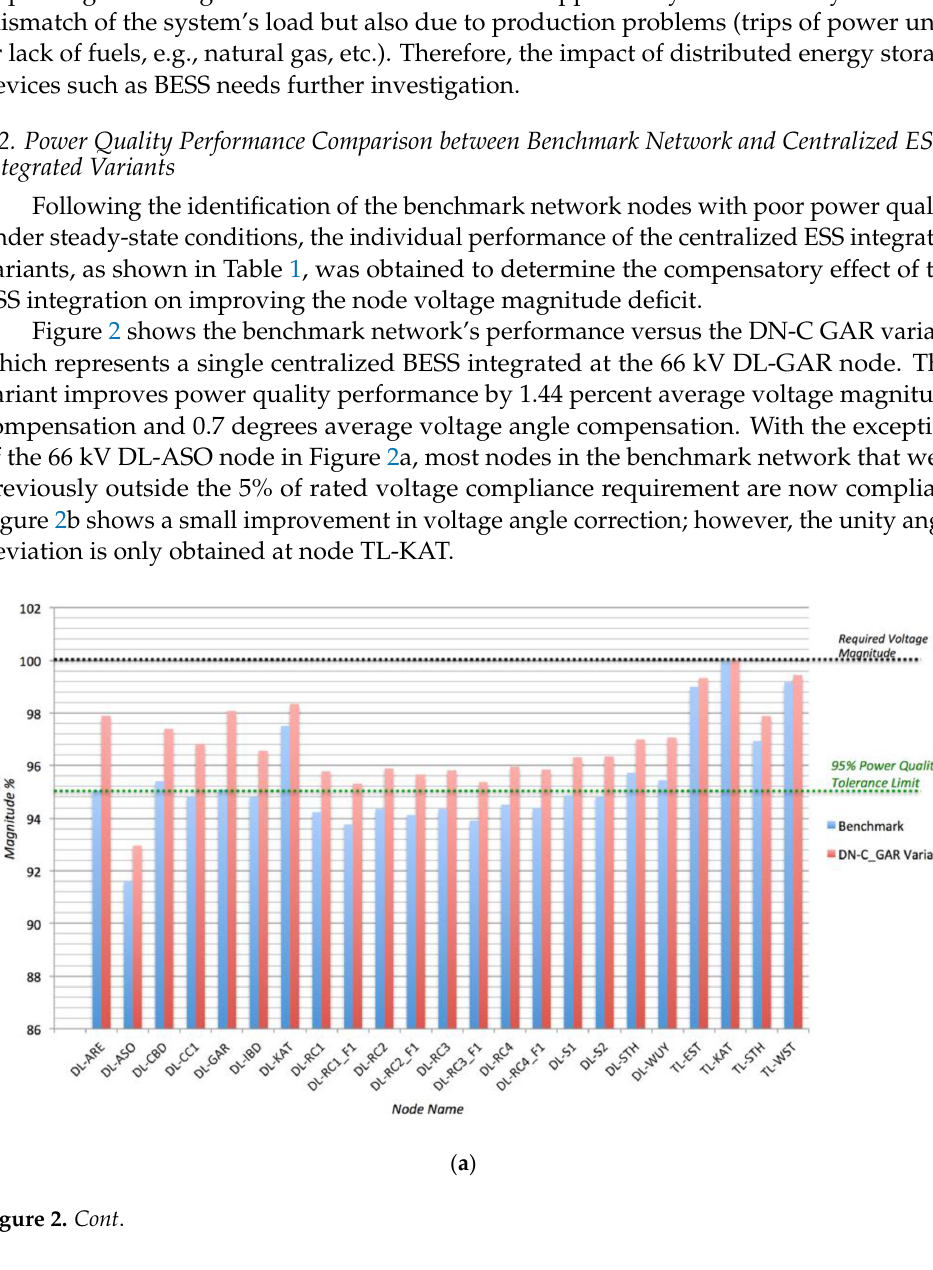
( b ) Figure 2. Graph indicating the effect of DN-C_GAR variant on ( a ) the voltage magnitude compen- sation; ( b ) the voltage angle deviation compensation. Table 3. Power Quality Performance of the Respective Benchmark Network Variants. Variant Name